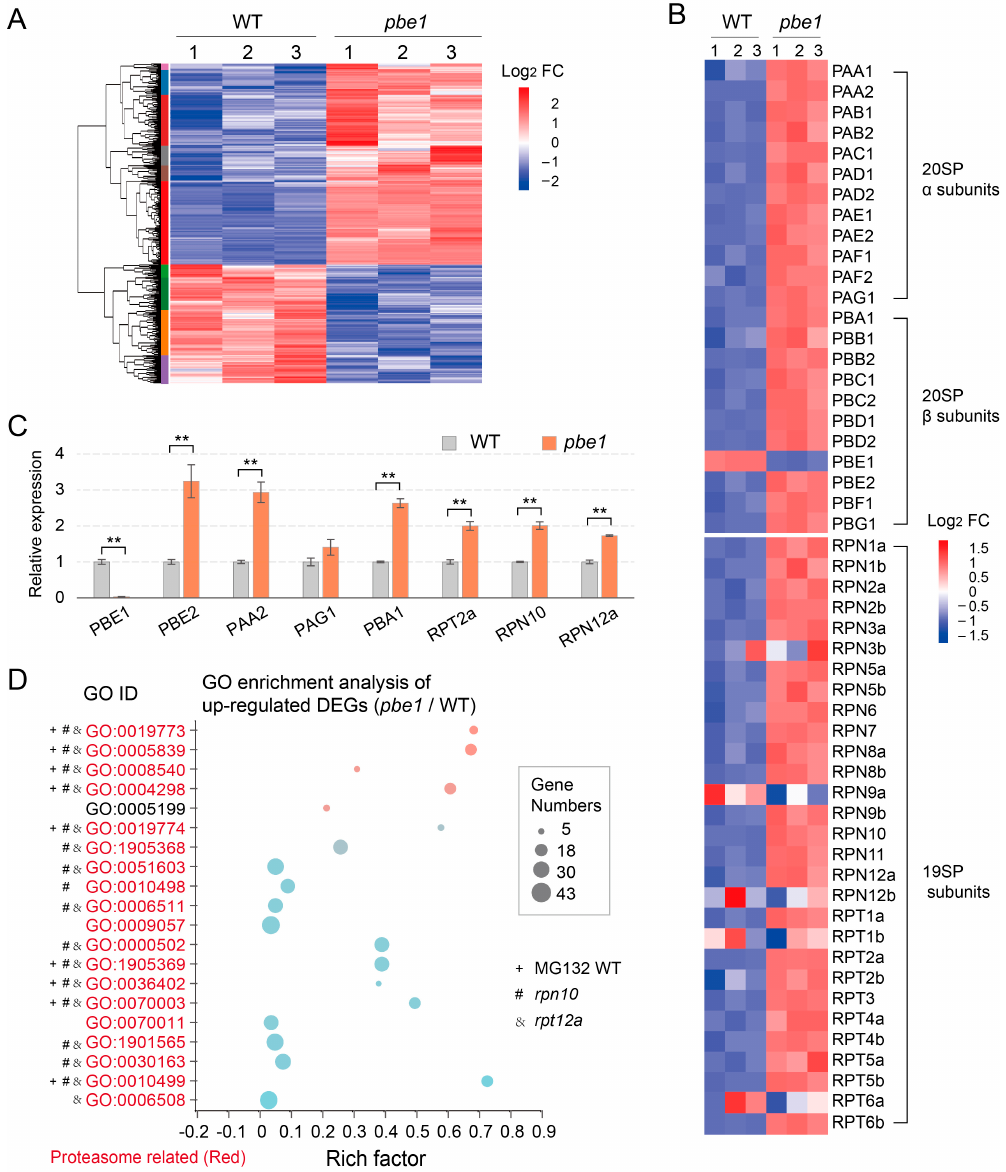
Figure 2. RNA-Seq analysis of the pbe1 mutant. ( A ) Heat map showing the expression patterns of the up- and down-regulated differentially expressed genes (DEGs) (absolute log2 fold-change ≥ 1 and Q-value ≤ 0.05) in the pbe1 mutant compared to WT plants. Three biological replicates were conducted for each sample. ( B ) Heat map showing gene expression patterns of the proteasomal subunits in the pbe1 mutant compared to WT. Red and blue represent the relative expression of genes among different samples in the same row. ( C ) The expression of several key proteasome subunit genes was detected by RT-qPCR. The expression level of each gene was firstly normalized to that of the housekeeping gene PP2A or ACTIN . Then, the expression level in WT was set to one, and the expression level in pbe1 was compared with that in WT to obtain the relative expression level. Data are the mean ± SD, n = 4. Significance analysis of differences was performed by t -test ( ** p < 0.01). ( D ) Gene Ontology (GO) analysis of upregulated DEGs showed that GO terms associated with proteasome were enriched. The marked GO terms were also enriched in upregulated DEGs in rpn10 , rpt12a mutants, or MG132-treated WT seedlings (see Table S2 for details of the enriched GO terms of upregulated DEGs).